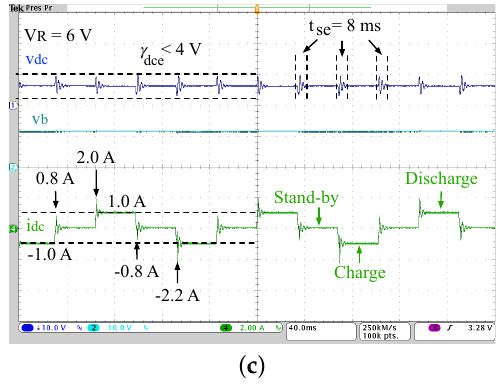
Figure 13. Voltage regulation of the DC-bus for 1 A current steps. ( a ) Boost operation mode with V R = 24 V; ( b ) Buck–Boost operation mode with V R = 12 V; ( c ) Buck operation mode with V R = 6 V.